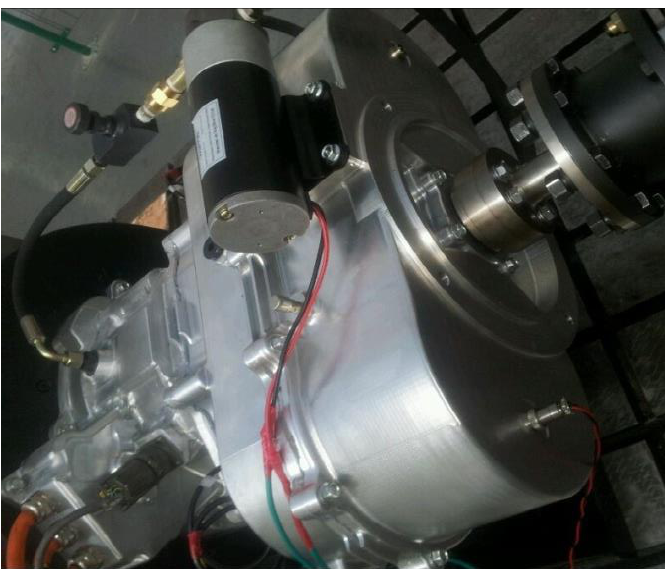
Figure 5. i-KERD in the FR/MR chassis.